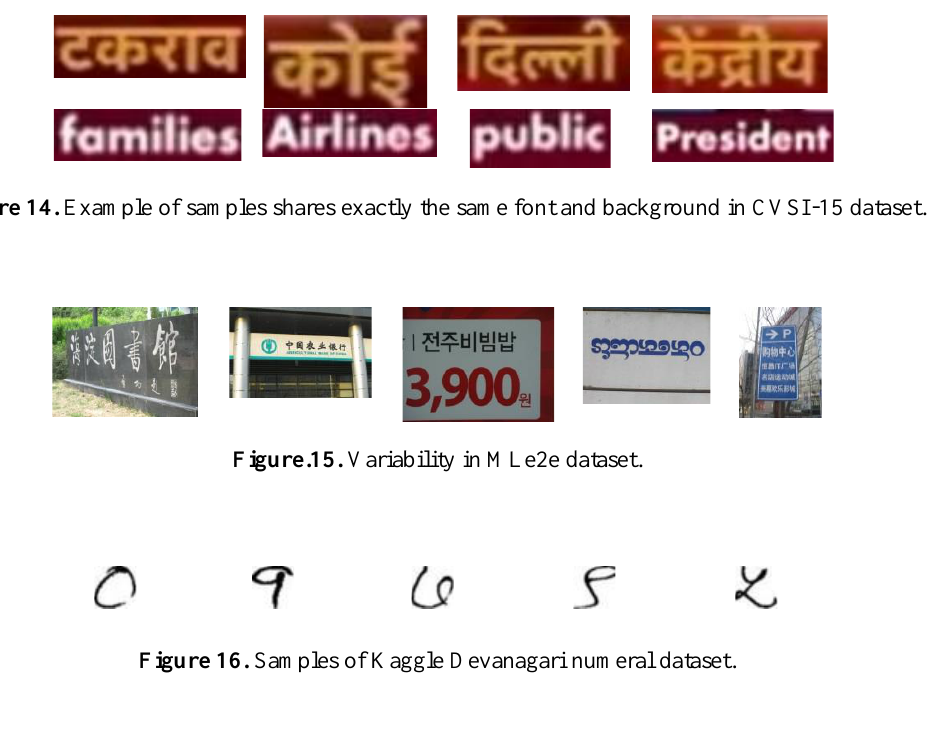
Table 3. Overall classification performance comparison with some other methods in three